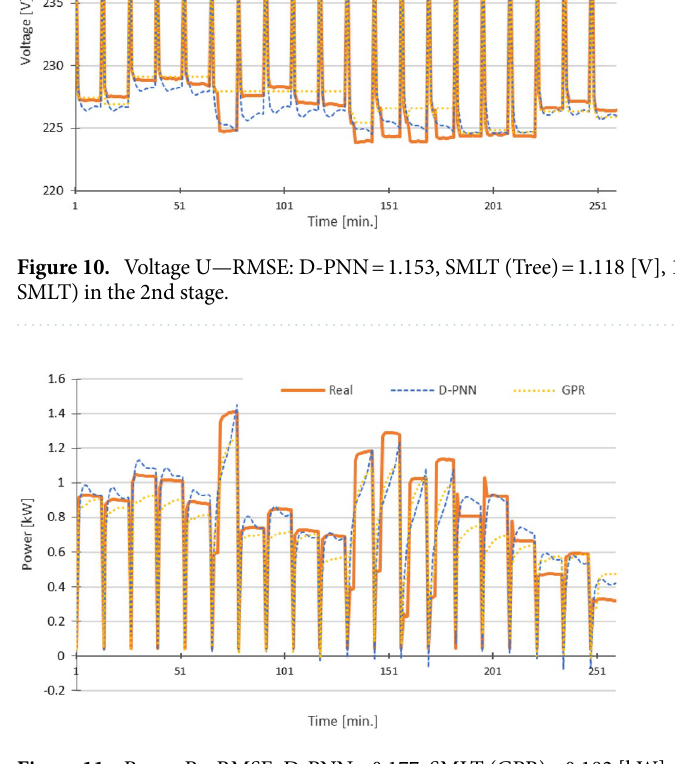
Figure 11. Power P—RMSE: D-PNN = 0.177, SMLT (GPR) = 0.182 [kW], 12 inputs + U + PF (D-PNN), 12 inputs + PF + THDU (SMLT) in the 3rd stage.